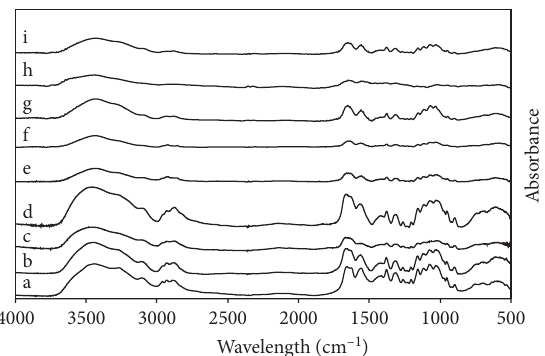
Figure 8: FT-IR spectra of the (a) extracted chitin, (b–e) C1-3 to C1-10, and (f–i) C2-3 to